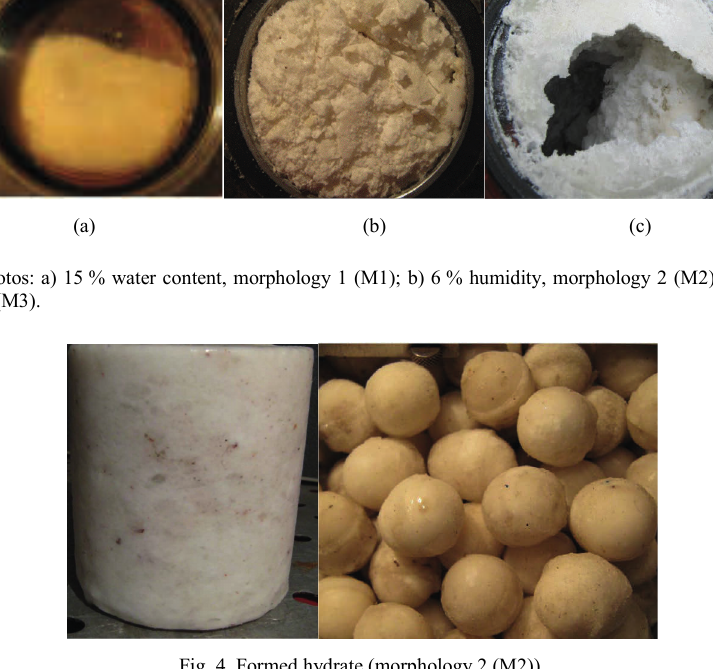
Fig. 4. Formed hydrate (morphology 2 (M2)).